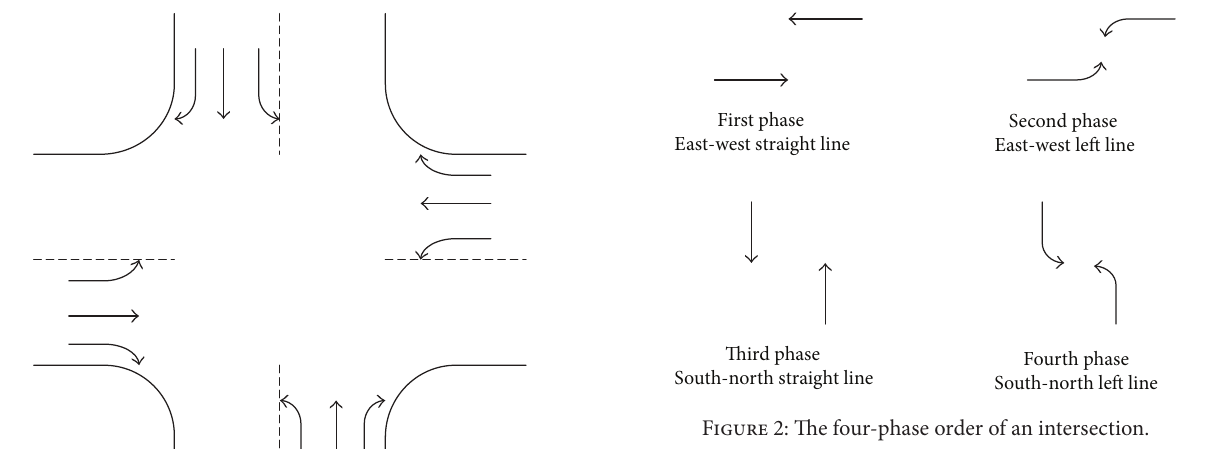
to fuzzy traffic flow [11]. Pranevicius and Kraujalis presented a traffic signal control method based on fuzzy logic for an isolated signalized intersection. The current green signal can be extended or terminated in response to changing traffic conditions [12].